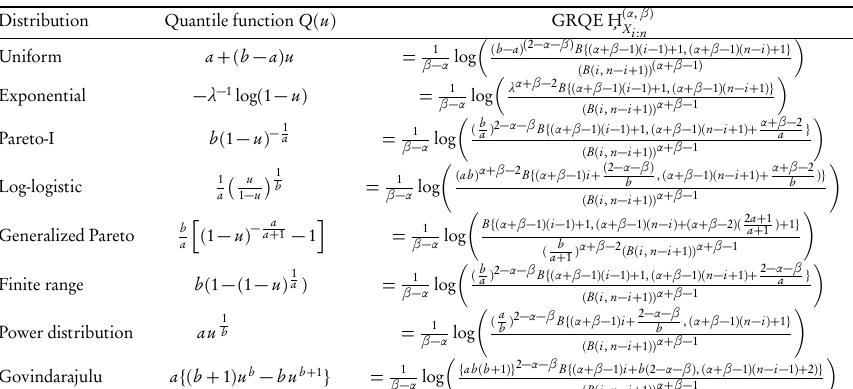
( α , β ) of i th order statistics for different lifetime X i : n